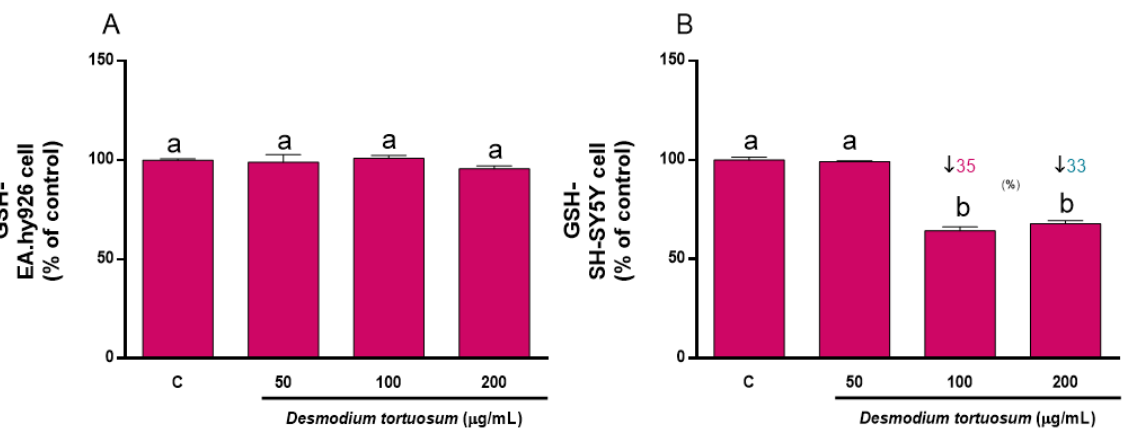
Figure 5. Direct effect of D. tortuosum extract on GSH levels in EA.hy926 ( A ) and SH-SY5Y ( B ) cells after a 22 h of treatment period. GSH levels was determined as % of control-change, and represent the mean ± SEM of four independent experiments. a,b,c Different letters show significance between groups at p < 0.05. ↓ represents percentage decrease with respect to control.